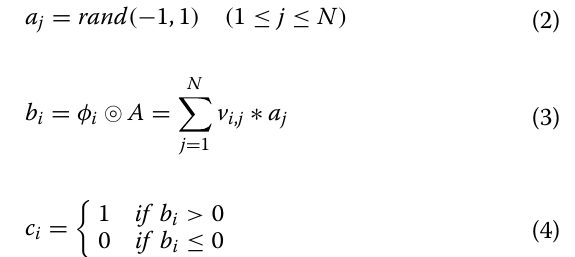
· · · { S 1 , S 2 , , S M }; each sensor can monitor N environment value b i as formalized in (3). Next, we execute the conver- indicators or criteria (e.g., temperature, humidity, light, sion or transformation presented in (4) to build a mapping · · · 1 ≤ i ≤ M and so on), represented by Set N { I 1 , I 2 , , I N }; at a cer- from b i to c i ( ). More concretely, if b i is positive, = 1 ≤ j ≤ N tain time point, the I j ( ) value monitored by the then c i would be equal to 1; otherwise, c i would be equal , j 1 ≤ i ≤ M sensor S i ( ) is denoted by v i . Thus, at a certain to 0. The more intuitive explanation of the conversion point, the monitored environment data by all the sensors from b i to c i is: we randomly pick out a hyperplane A to can be formalized with a matrix V in (1). For example, the divide the whole space into two parts; if point b i is above , · · · , v 1, first row of matrix V , i.e., φ 1 = ( v 1,1 the hyperplane A , then we record c i 1; otherwise, if point N ) represents = the first sensor, i.e., S 1 ’s monitored data over N environ- bi is below the hyperplane A , then we record c i 0. Then = · · · ment indicators I 1 , I 2 , , I N . according to the above analysis, if two points b i 1 and b i 2 are both located on the same side of the hyperplane A , then b i 1 and b i 2 are more likely similar.